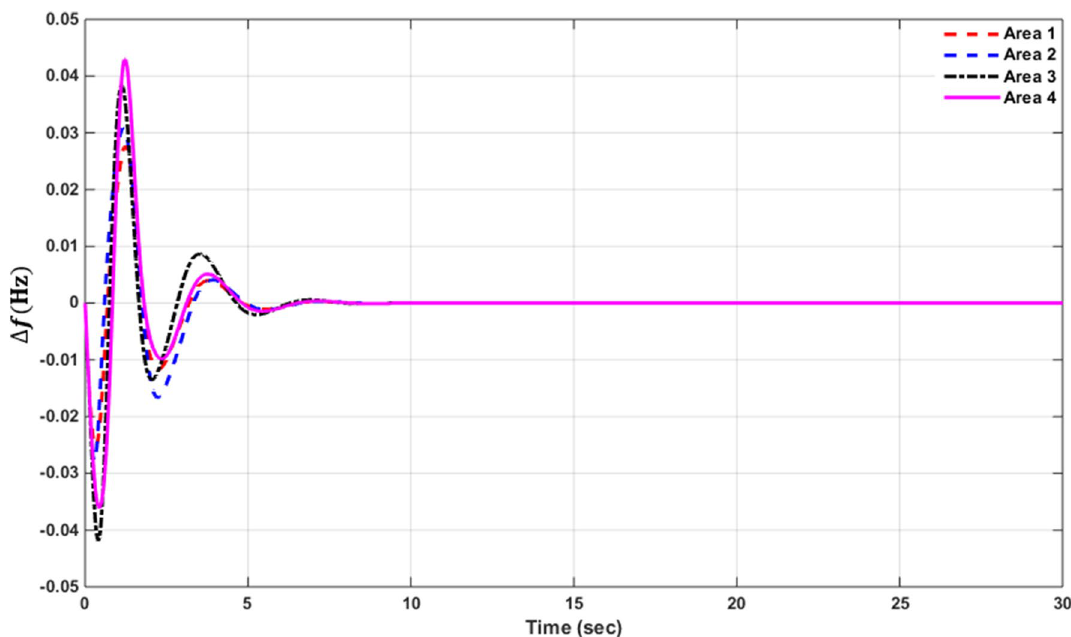
Figure 5. Frequency deviations in four control areas without